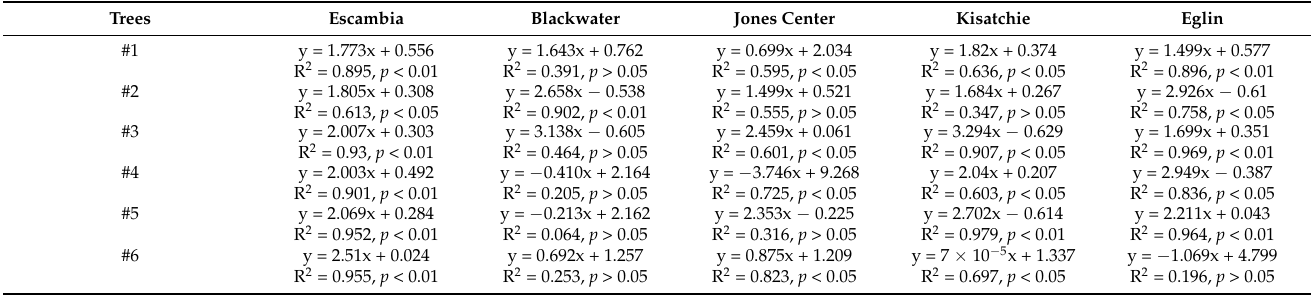
Figure 2. The entropy of cone production of each tree with time (#1, 2 . . . 10 represent 10 trees). Table 3. Taylor’s law in the cone production of ten monitored longleaf pine trees at different sites (y = log(variance), x =